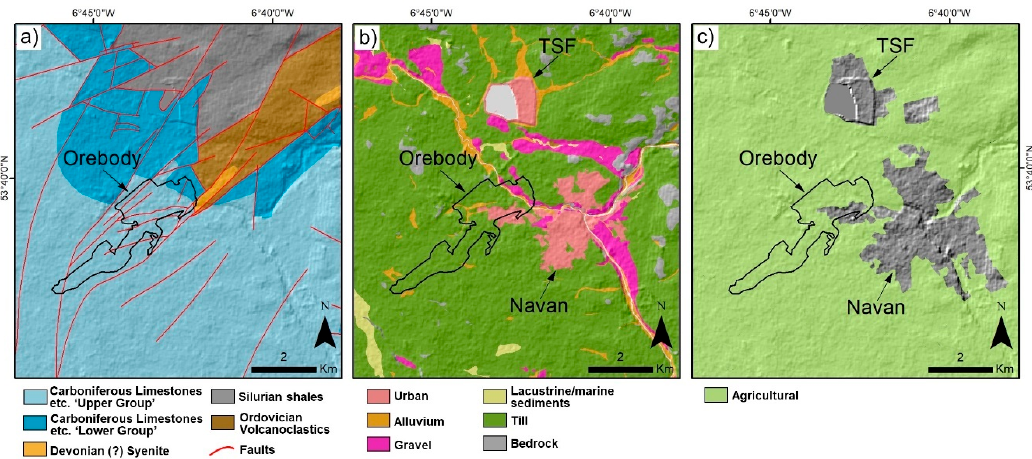
Figure 5. Maps of ( a ) bedrock geology, ( b ) superficial deposits and ( c ) vegetation land-cover in AOI-2. The black polygon shows the simplified subsurface extent of the Navan orebody (after [46] ). ‘TSF’ is the Tailing Storage Facility. The base image is a shaded relief map derived from the 30 m Shuttle Radar Topographic Mission (SRTM) digital elevation model (DEM). Boundary data in parts ( a ) and ( b ) are modified from the GSI 1:100,000 bedrock and Quaternary digital geological map series. Note that the assignment here of the Carboniferous formations into ‘lower’ and ‘upper’ groups is informed by the works of [47] and [48] and is based on local mining convention (i.e., is not a regional stratigraphic division). Data in part ( c ) are modified from the CORINE 2012 land-cover inventory.